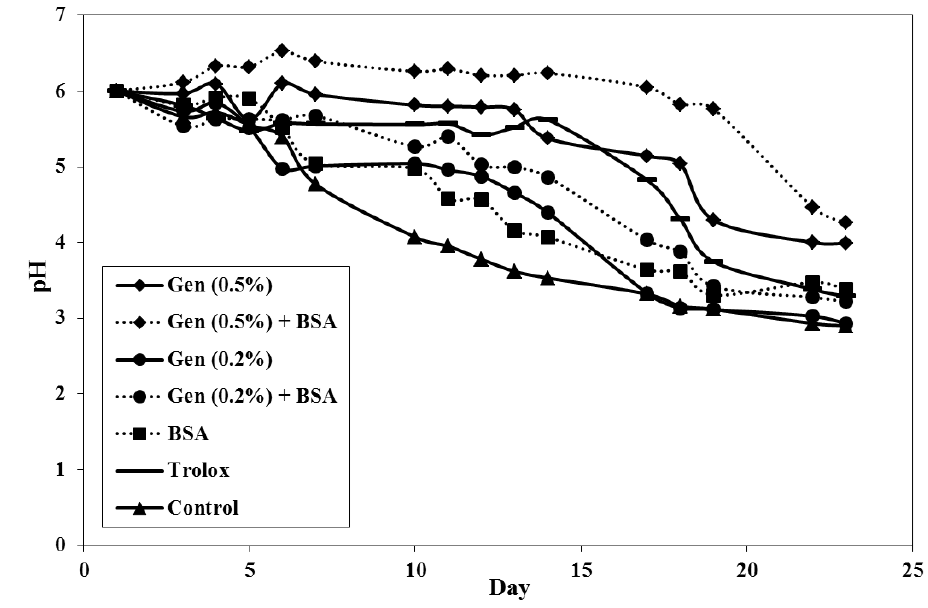
Figure 2. Change of pH over time, stored at 37 °C (each value is expressed as mean ( n =